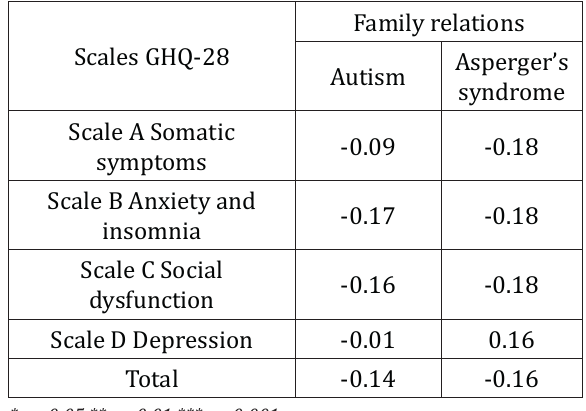
Table 8. Correlation coefficients calculated between the assessment of family relations and the scores of the GHQ-28 Questionnaire in the group of mothers of children with autism and Asperger's